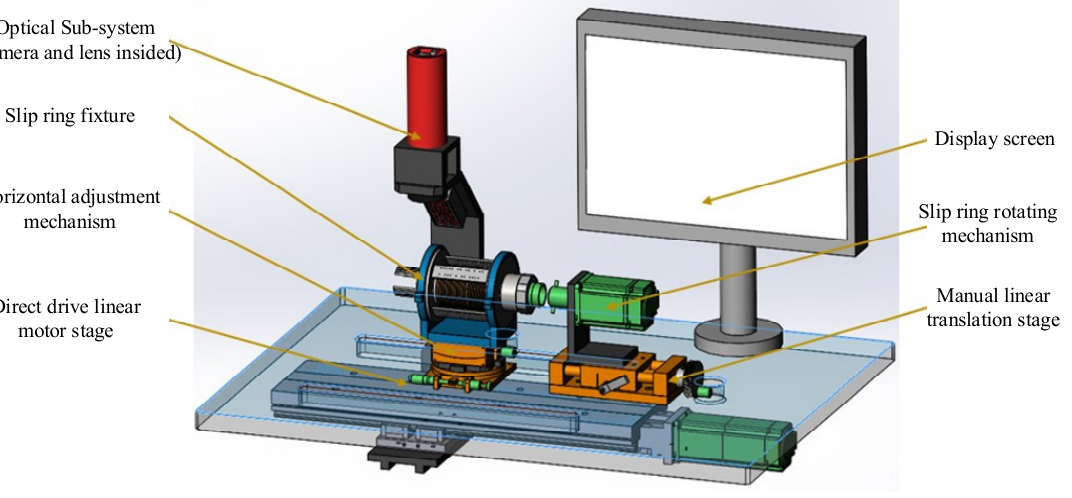
Figure 2. Schematic diagram of the vision-aided brush alignment assembly system.